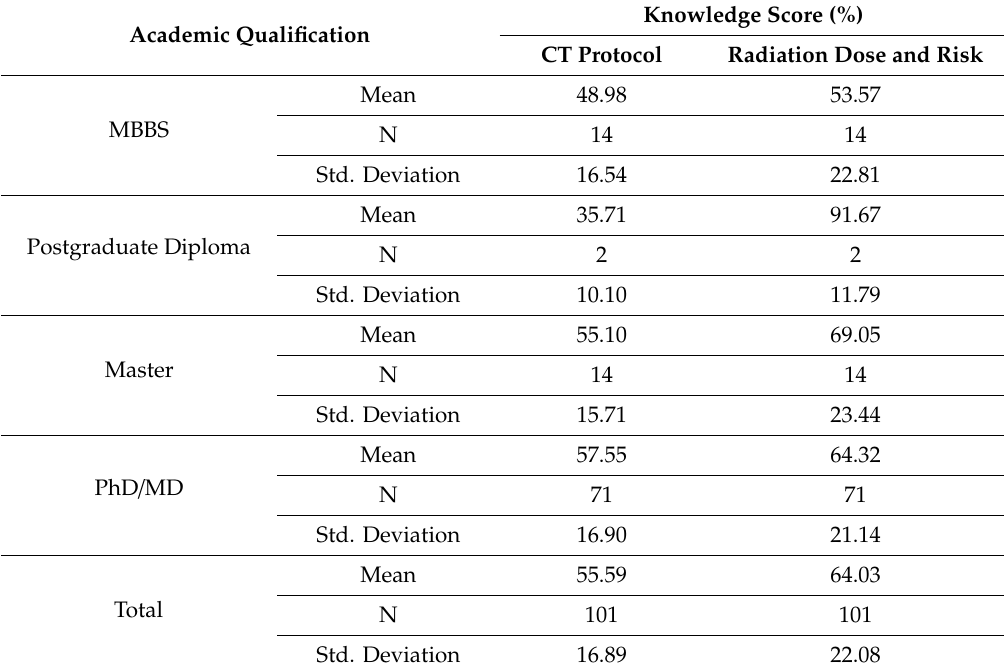
Table 3. Comparison of participants’ knowledge of CT protocol and radiation dose based on academic